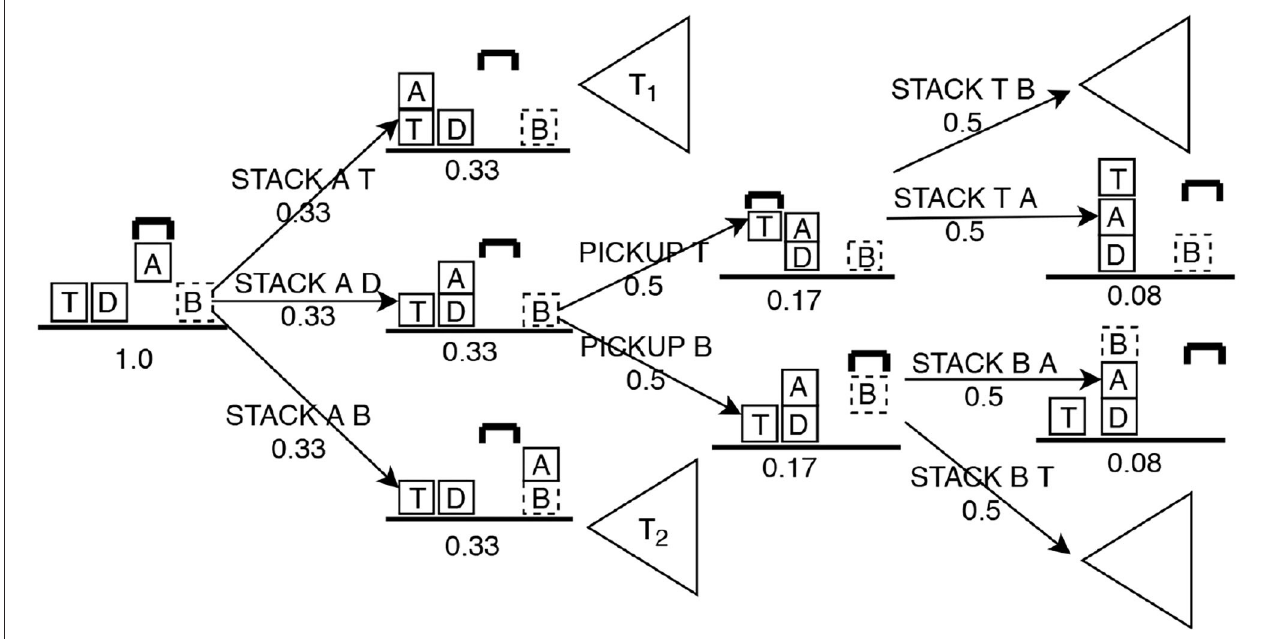
FIGURE 3 | Fragment of the decision space after PICKUP A has been proposed for block-words example in Figure 2B . Numbers under each state and action indicate the probability. Sub trees T 1 and T 2 are not expanded for simplicity.